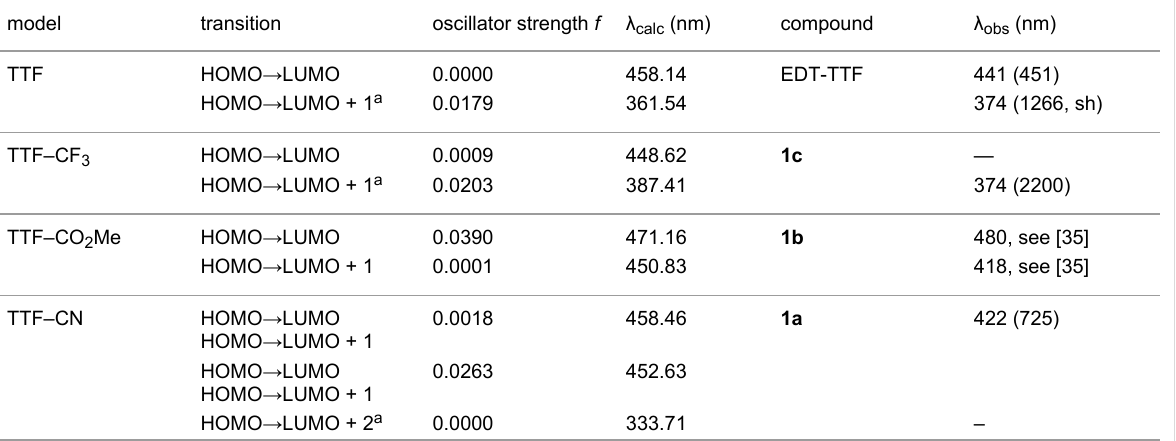
Table 3: Calculated (TD-DFT, B3LYP/6-311G**) optical transitions in the model compounds TTF, TTF–CF 3 , TTF–CO 2 Me and TTF–CN, and compari- son with the experimentally determined values in the analogous EDT-TTF